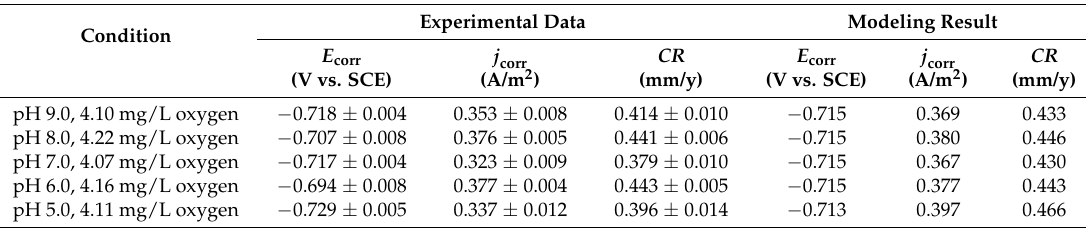
Table 5. The corrosion potential, corrosion current density and corrosion rate of Q345R steel in 1 wt.% NaCl solution 4.07 to 4.22 mg/L oxygen at different pH under 30 ◦ C, including the results fitted from the experiment data and calculated from the